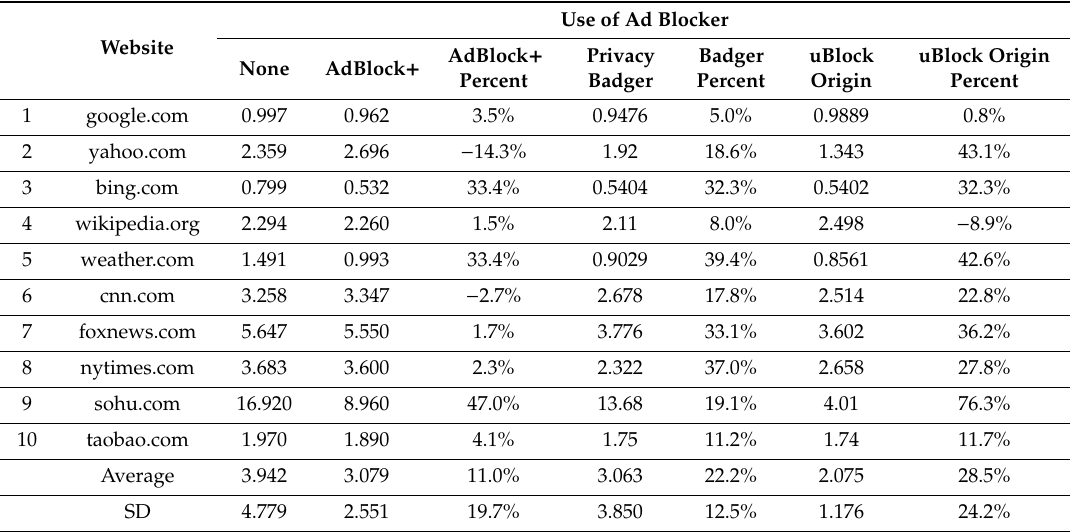
Table 2. Average page load times (in seconds) for no ad block, AdBlock + , Privacy Badger, and uBlock Origin as well as the percent of saved load time for each open source ad blocker.